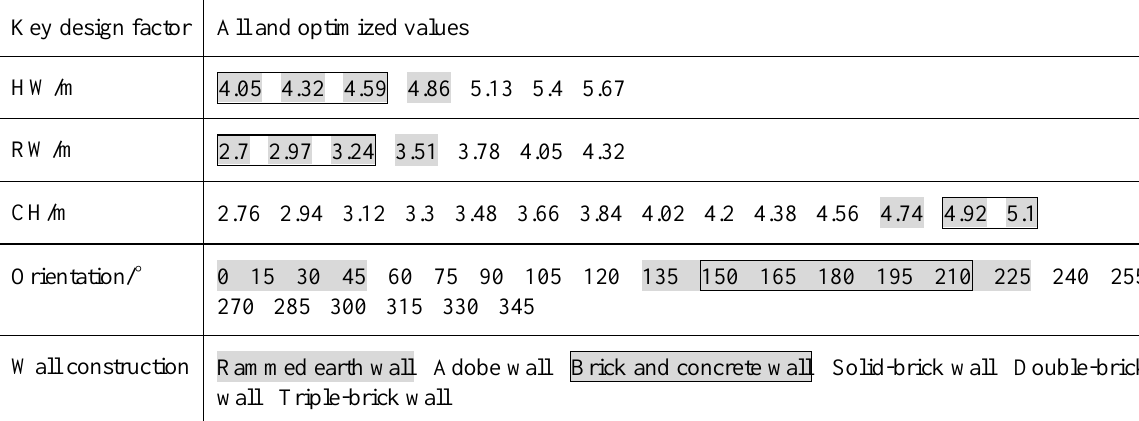
Table 7 The parameters for optimized climate-responsive